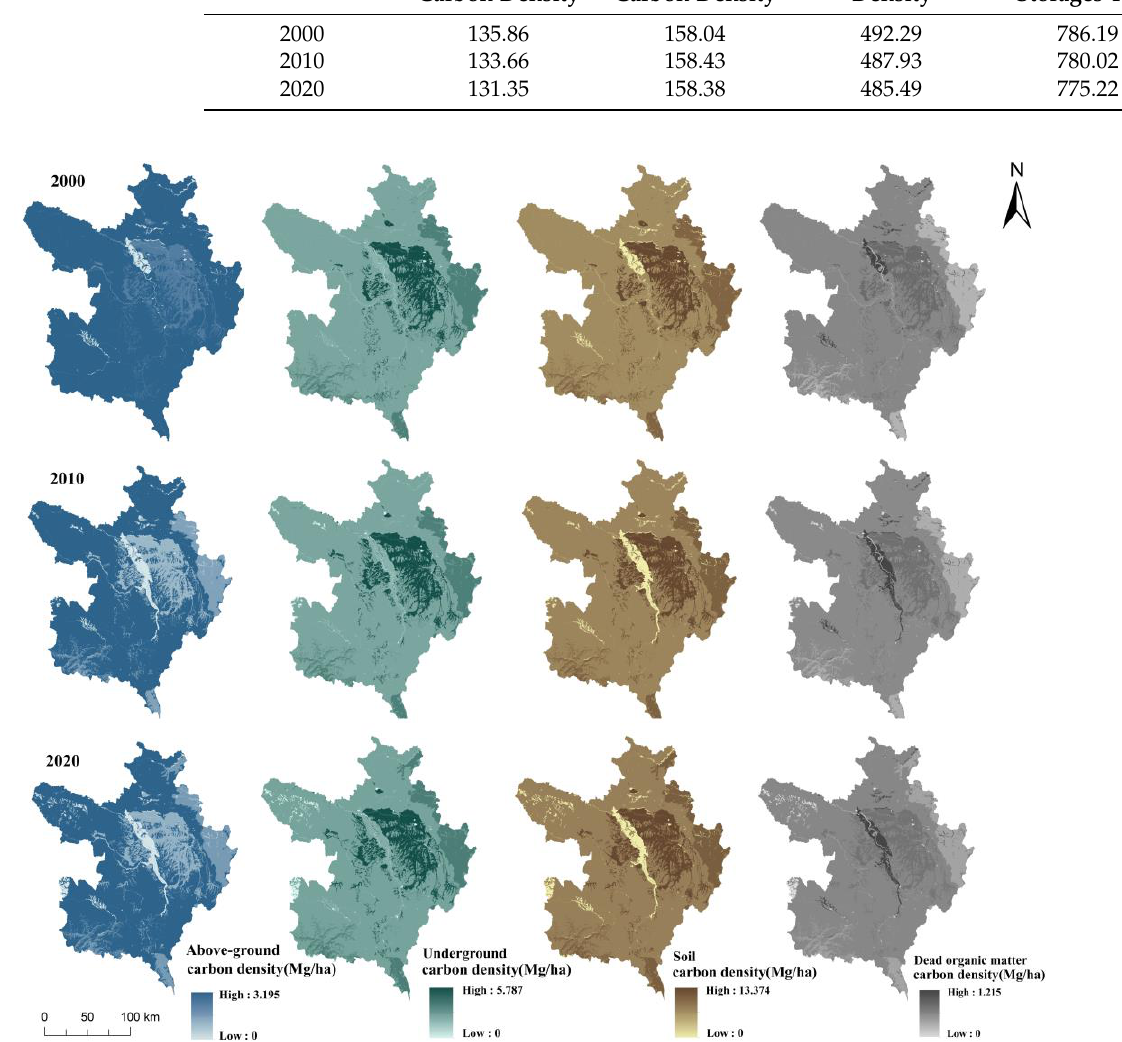
Figure 3. Distribution of various types of carbon pools in Zoigê alpine grassland.